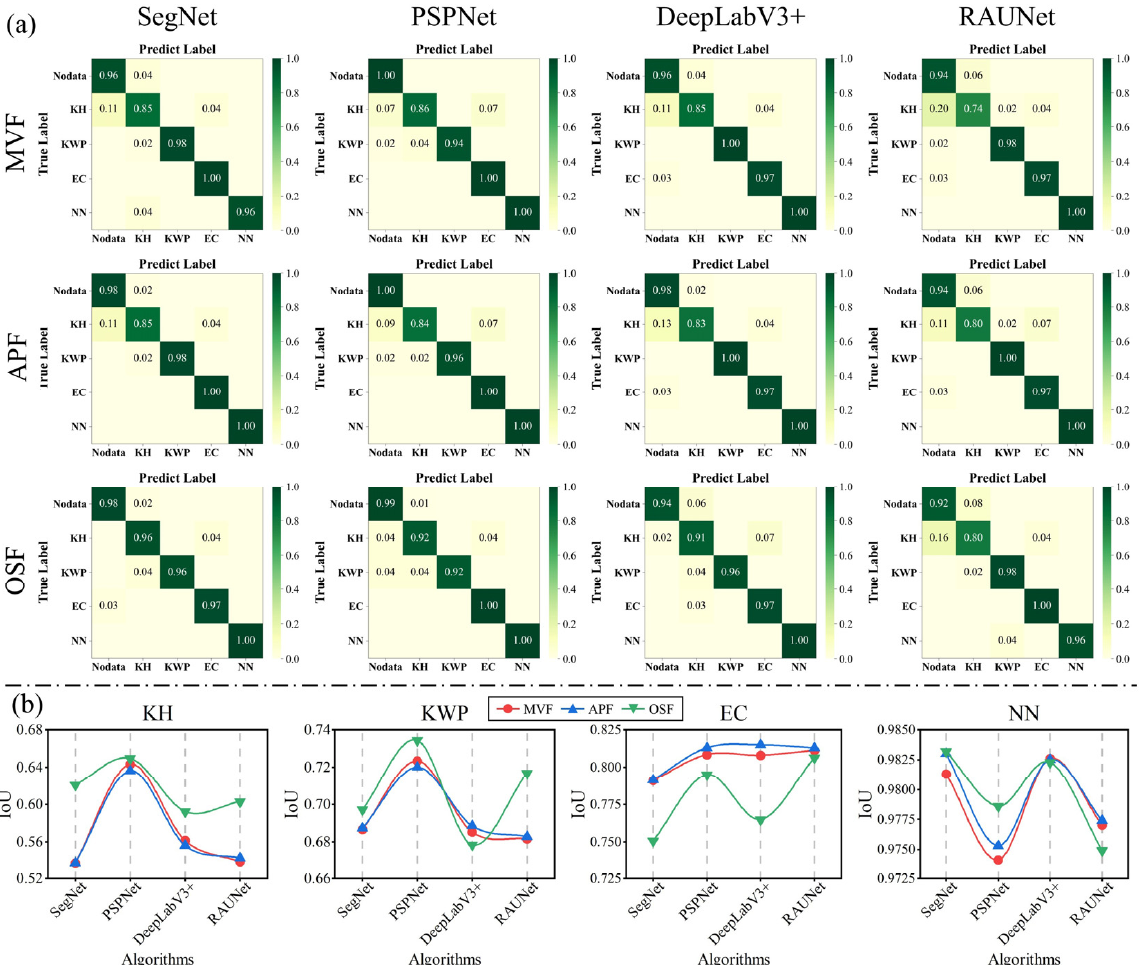
Figure 18. Differences in accuracy of OC-FCMs based on different algorithms for karst wetland vegetation. ( a ) Normalized confusion matrix, ( b ) IoU.